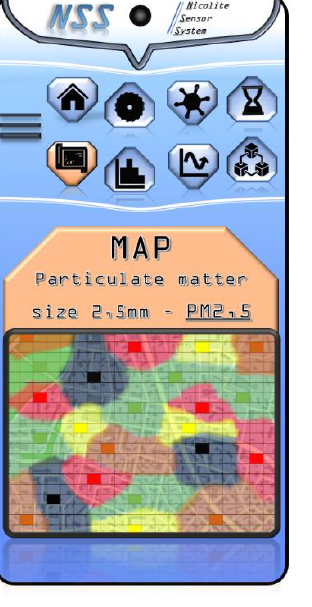
Figure 9. Schematic representation of the data processing application - Displaying a color plot of the measured particulate matter PM